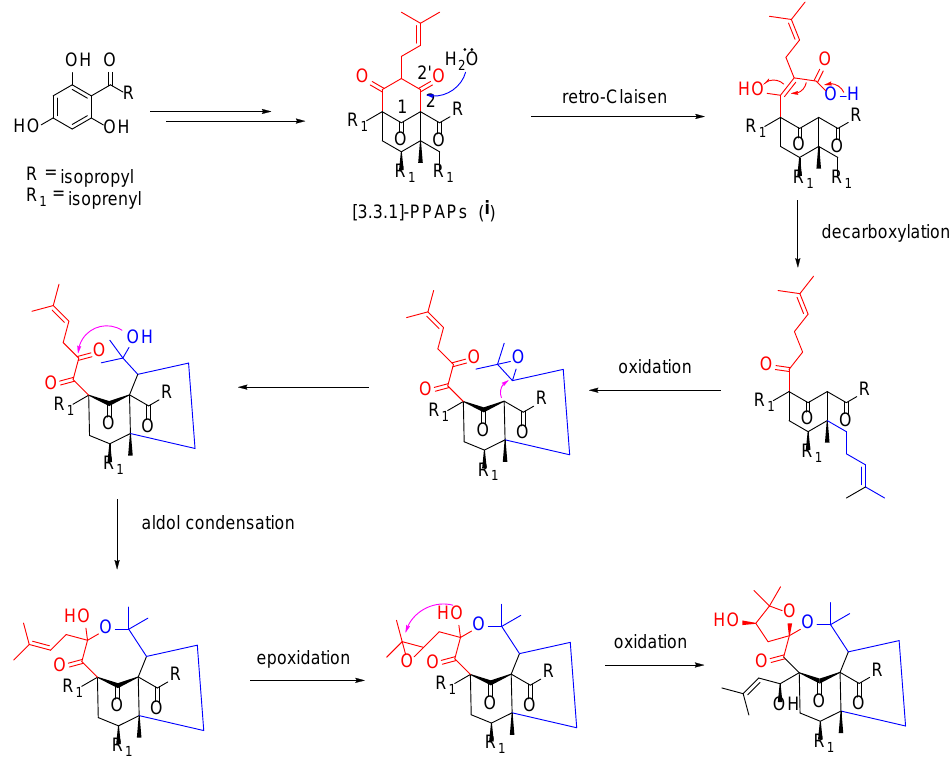
Figure 5. Plausible biosynthetic pathway for 1 .